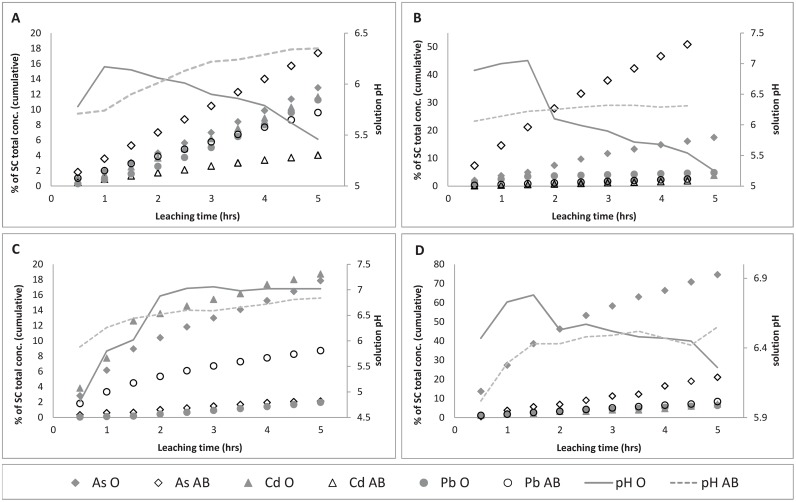
Desorption of As, Cd, Pb from SC after leaching with acidified (pH 3.4) deionized water.Desorption trends from SC, where initial sorption of studied PTE onto SC was in solutions of oxalic acid (A), formic acid (B), CaCl2 (C), deionized water (D).